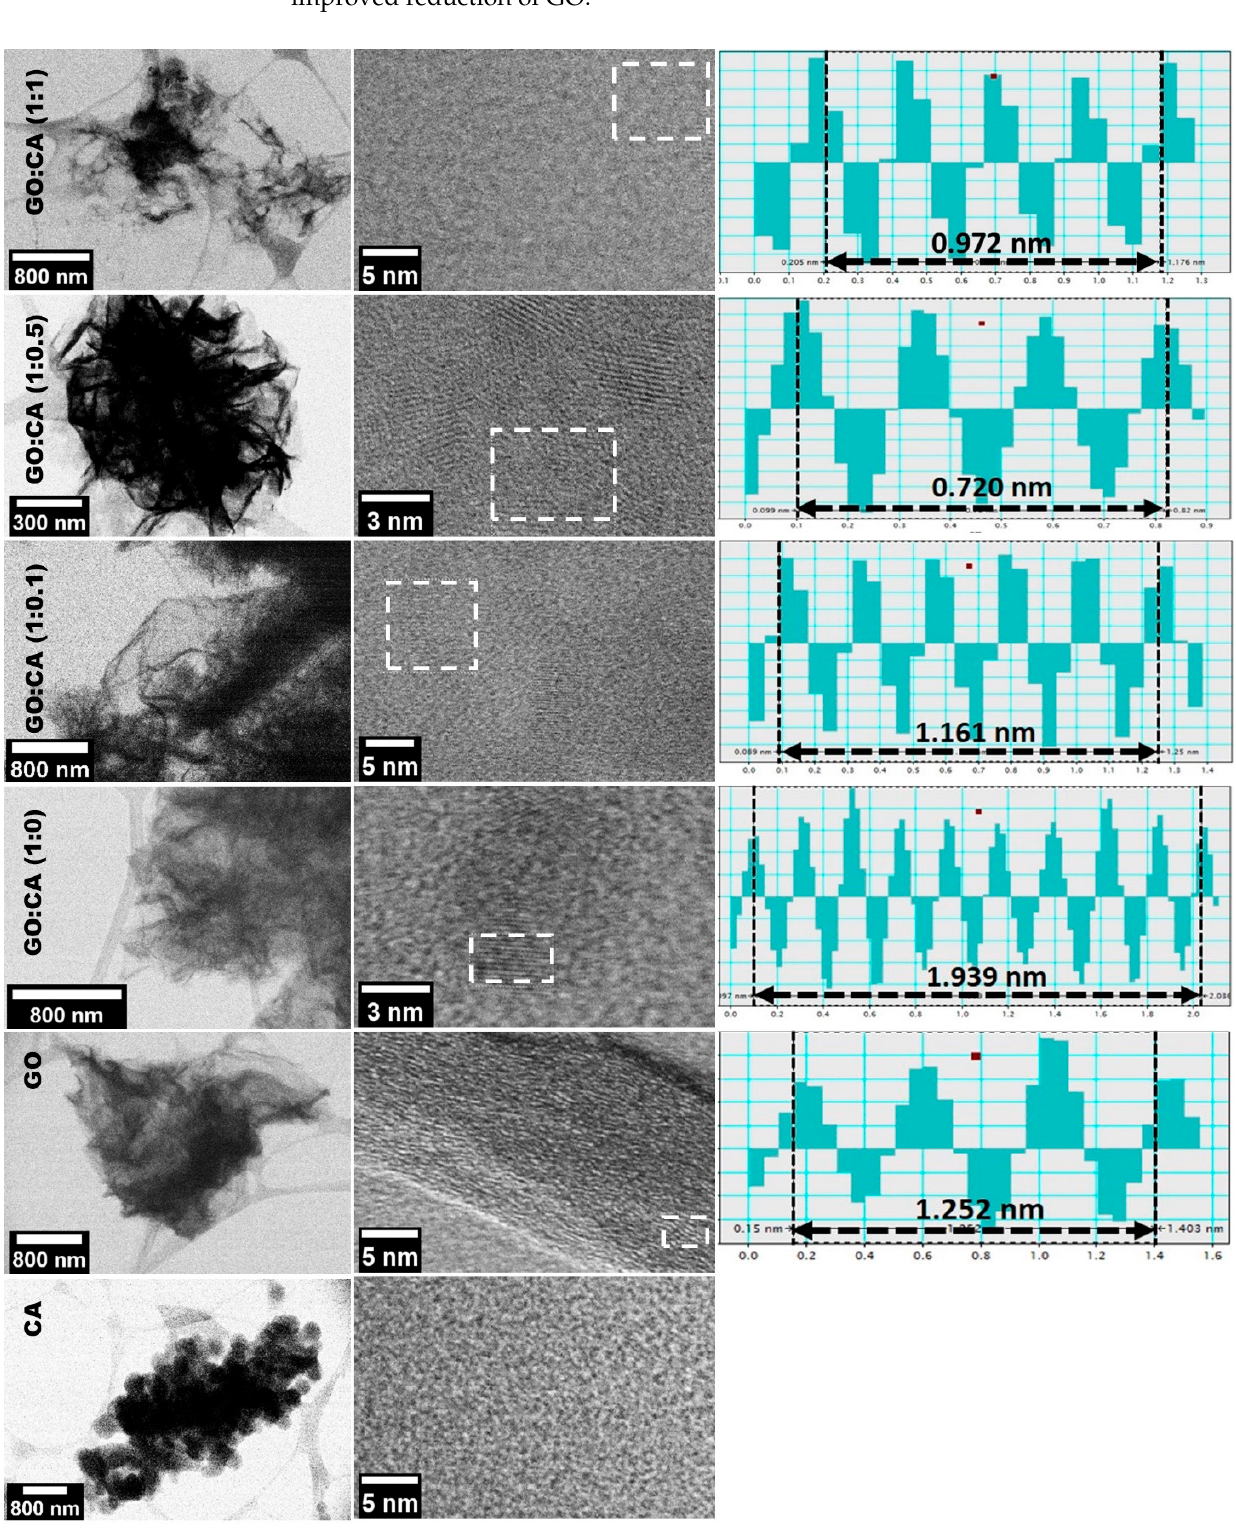
Figure 3. Scanning electron mode (STEM) (left column), high-resolution scanning transmission electron microscopy (HRSTEM) electron images (right column) and the respective determined profiles of hydrothermally reduced samples, GO and CA. The profile of CA sample could not be obtained as the sample was amorphous.